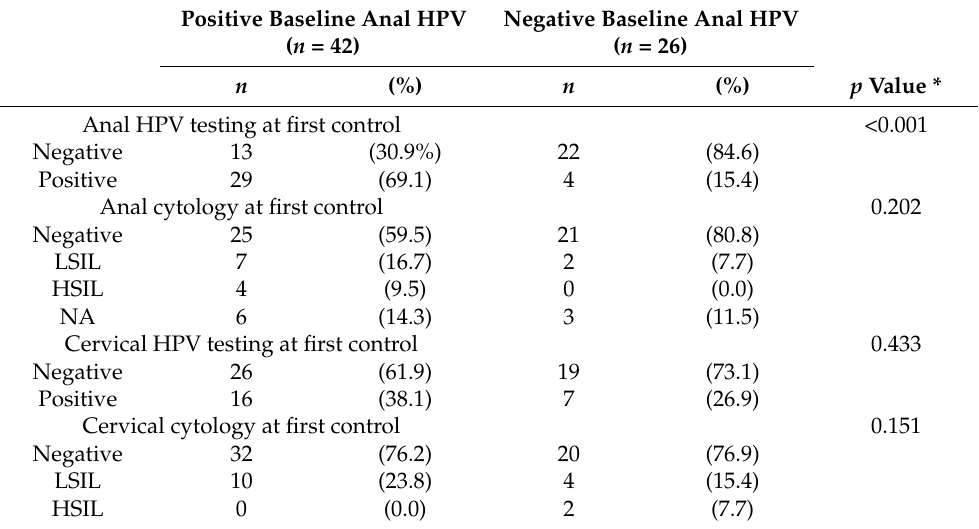
Table 3. Correlation between cervical and anal human papillomavirus (HPV) result and liquid-based cytology in the first follow-up control according to baseline anal HPV status.